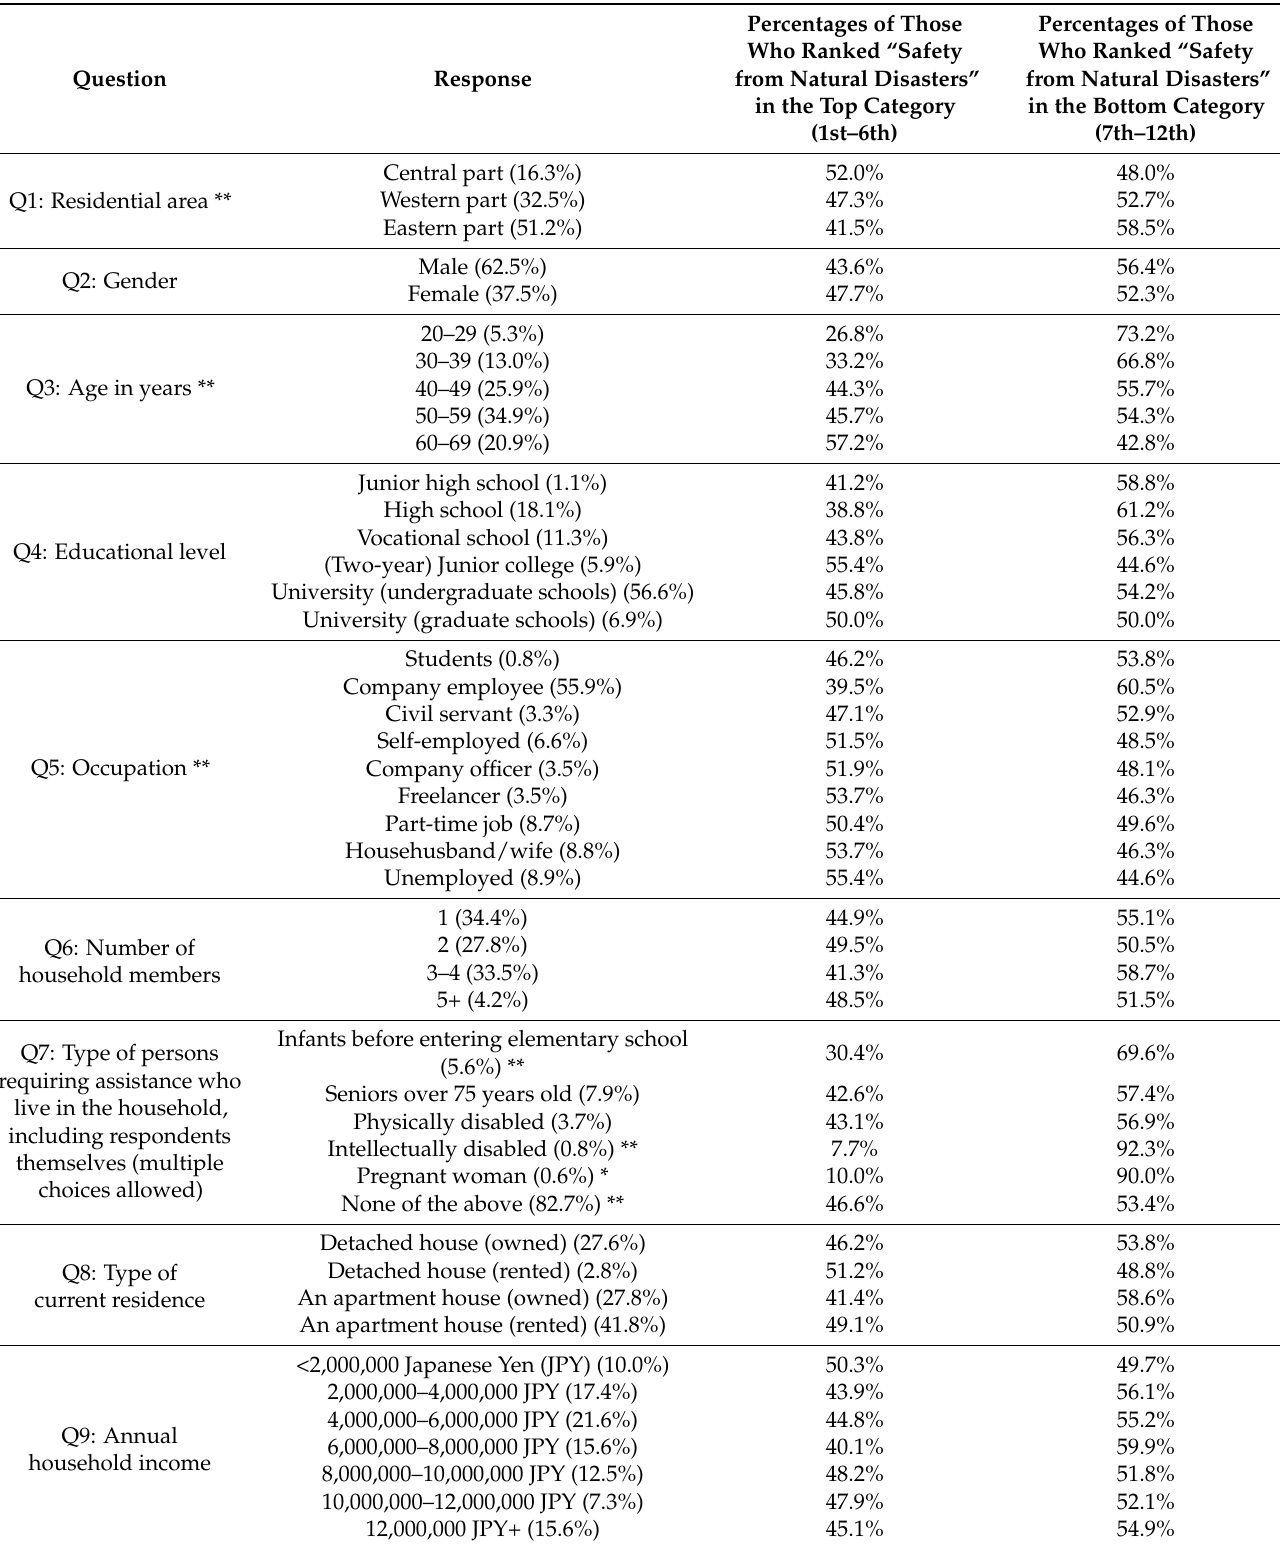
Table 1. Cross-tabulation results of the sociodemographic characteristics and the relative preference of “safety from natural disasters” in residential choices ( n = 1554). The number in parentheses indicates the percentage of the response for each